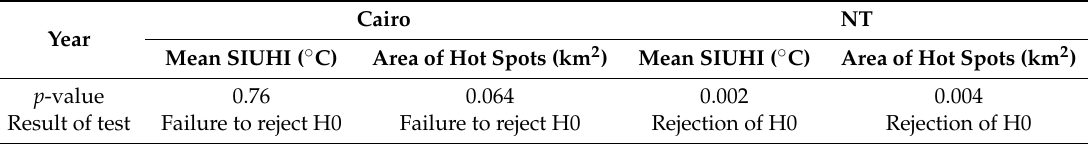
Table 8. The results of test of trend for the Mean SIUHI and area of hot spots in Cairo and